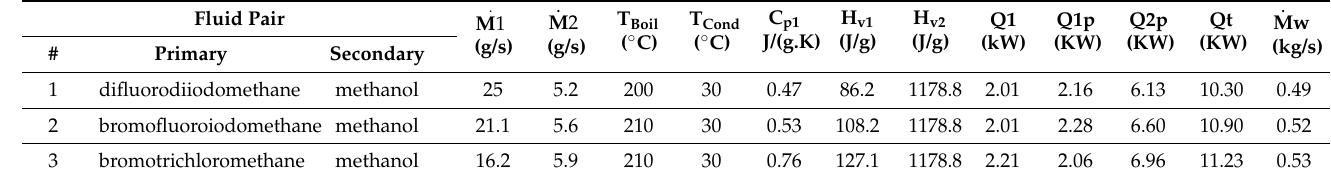
Table 2. Heat load for the condenser and cooling water flow rate for different binary fluid candidates.